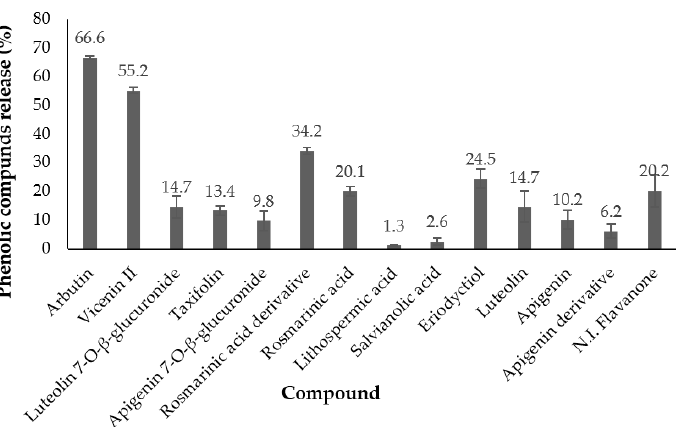
Figure 2. Amount (%) of phenolic compounds released after in vitro gastrointestinal digestion (mean ± SD, n = 3).